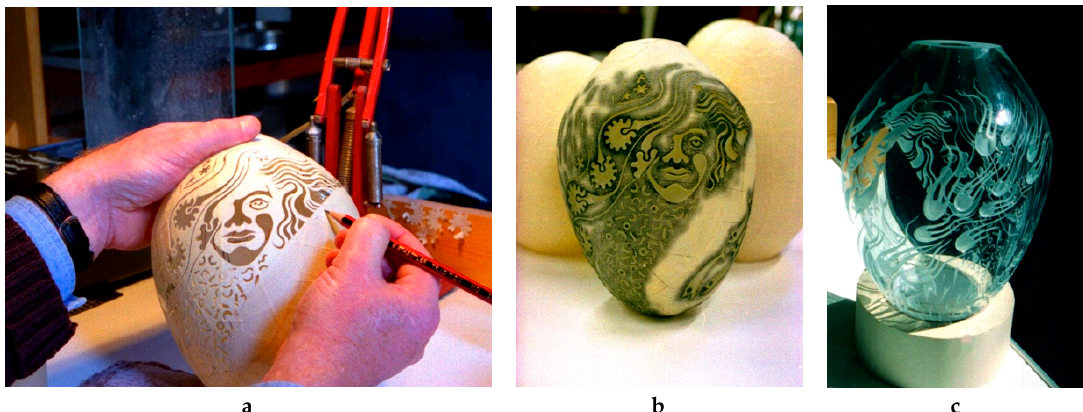
Figure 1. The stencil cutting and sandblasting process. Photographic source from Flavell’s (2001) PhD thesis. Used by permission.